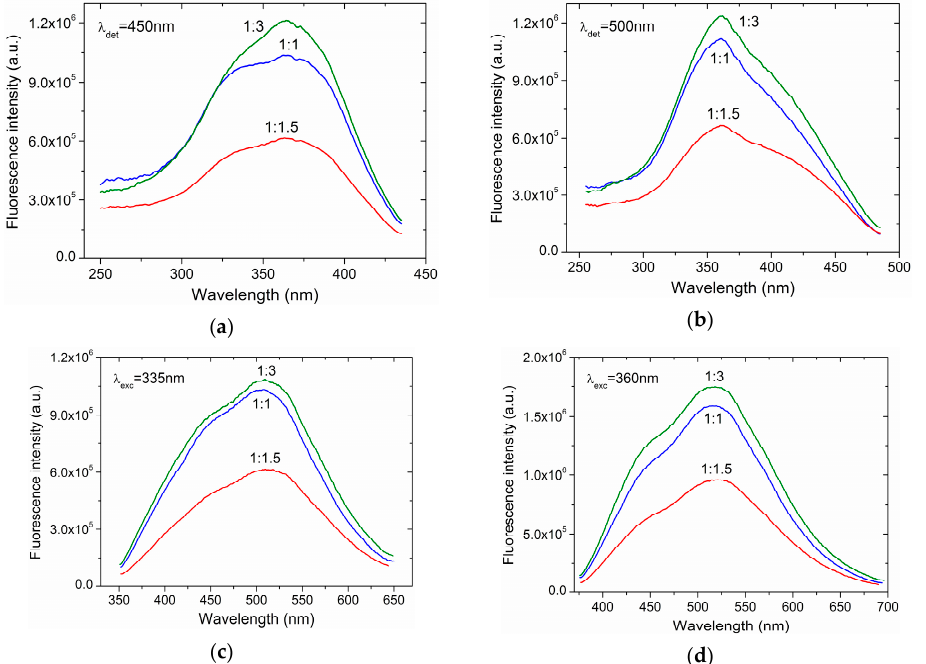
Figure 2. Excitation ( a , b ) and emission ( c , d ) spectra of the composites based on silica and citric acid thioureates (1:1, 1:1.5 and 1:3) after thermal treatment at 270 °C.